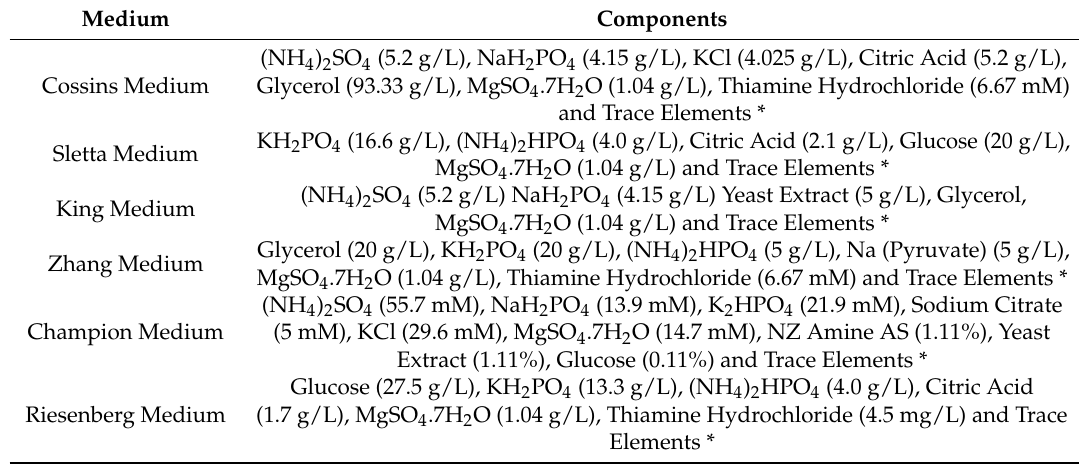
Table 1. The key attributes of different media that were screened for Fab